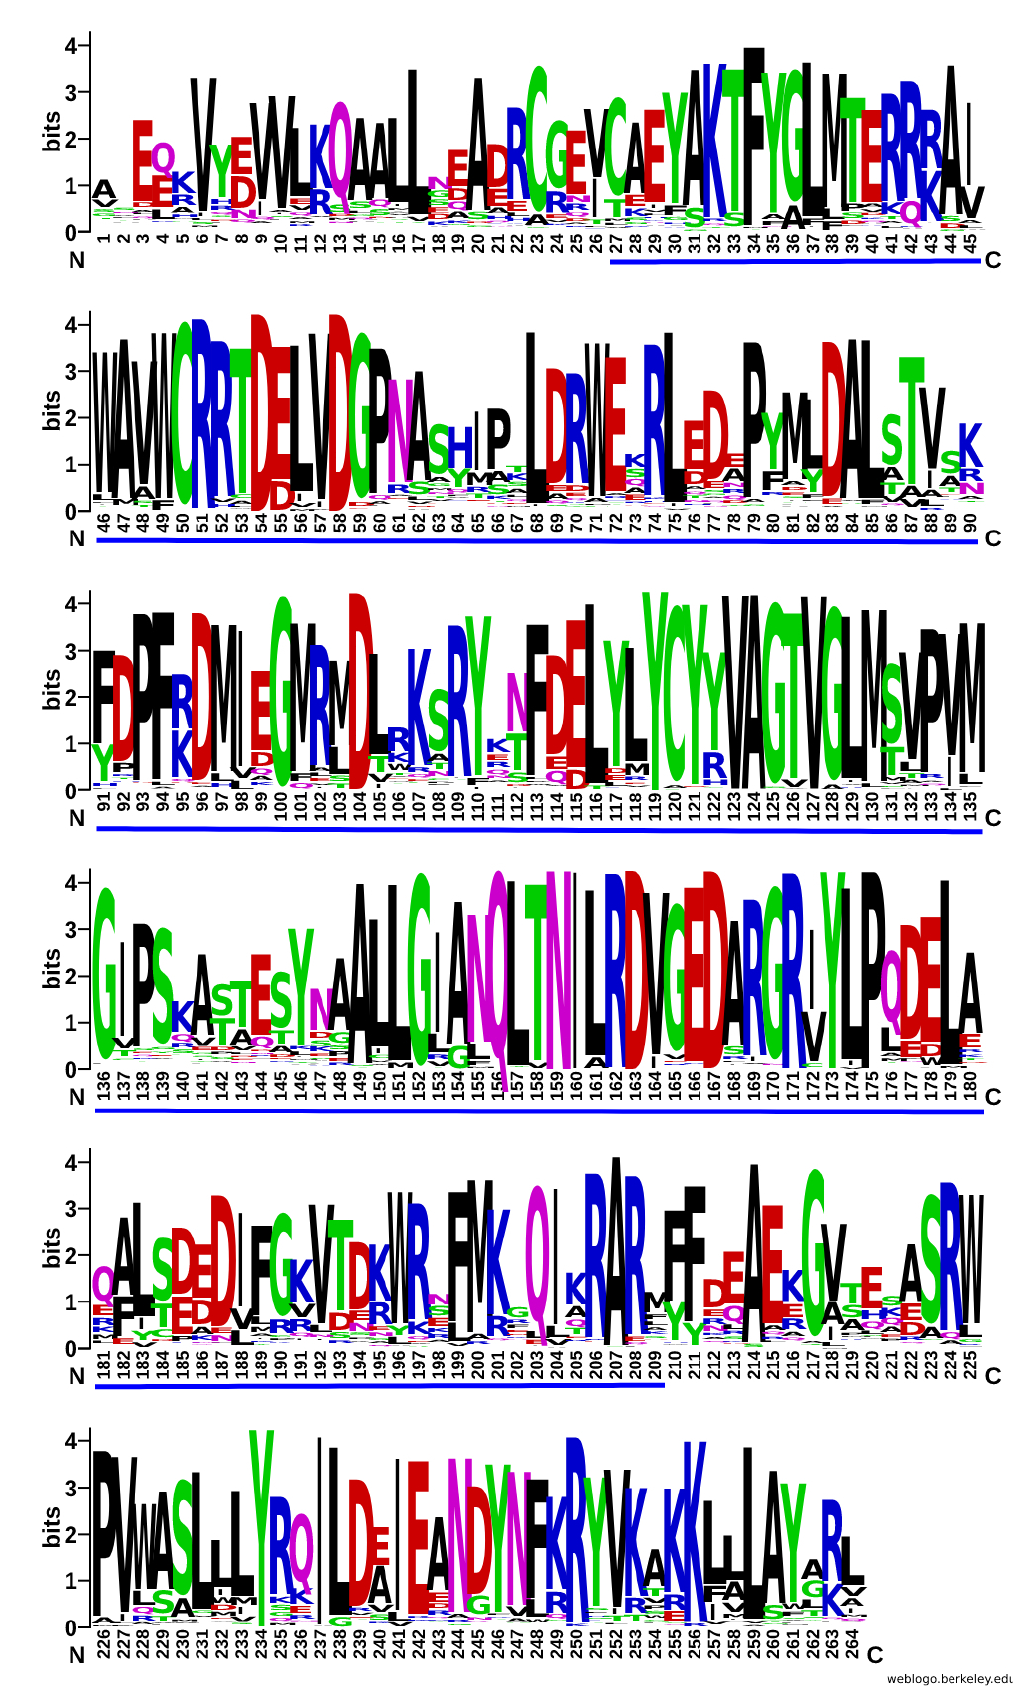
Figure 3 – Amino acid sequence logo of PSY alignments from angiosperm species, highlighting the high gene conservation. The vertical axis indicates information content of a sequence position, in bits (log2 4 = 2 bits for DNA/RNA, log2 20 = 4.3 bits for protein). The height of the y-axis is the maximum entropy for a given sequence type. The horizontal axis indicates the residue number. The blue line indicates the SQS_PSY